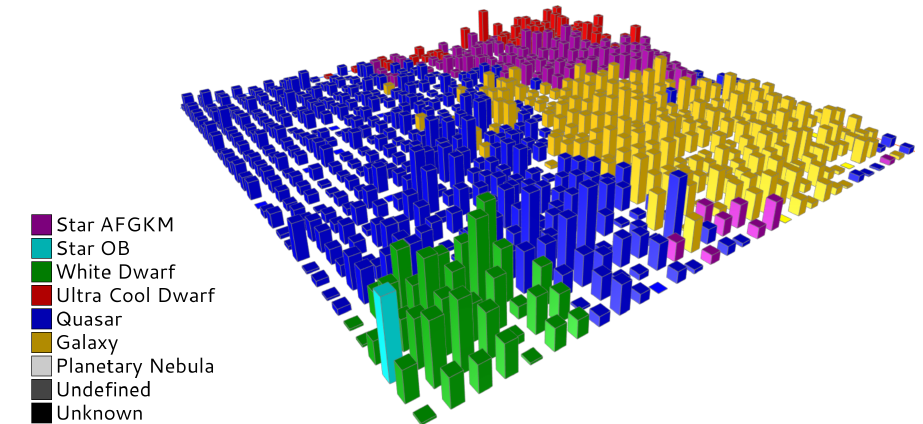
Figure 9. Combined view: the color related to each bar indicates the representative label determined by a template matching procedure on Gaia simulated data, whereas the height of the bar represents the number of elements populating such a